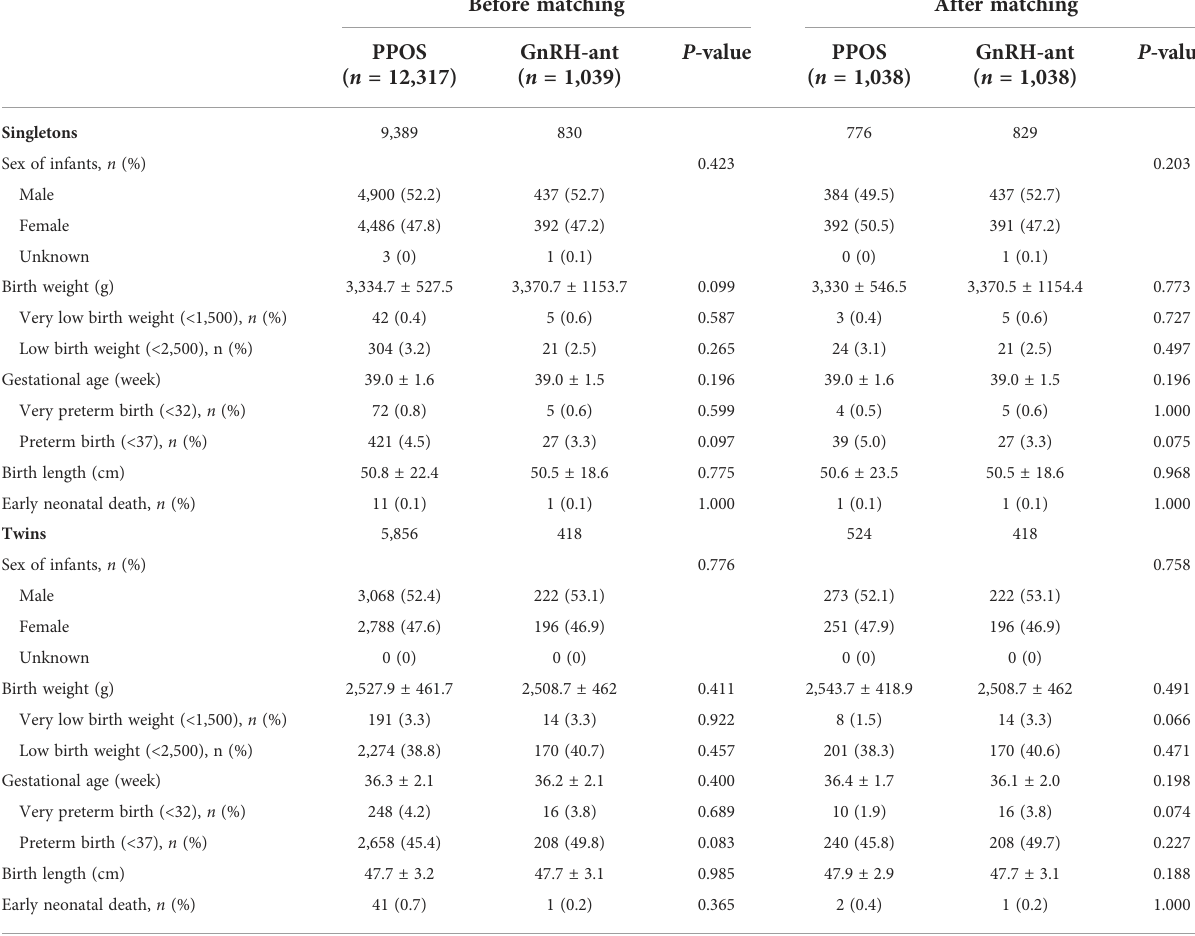
TABLE 2 Neonatal outcome of live-born singletons and twins between the PPOS and GnRH-ant groups. Before matching After